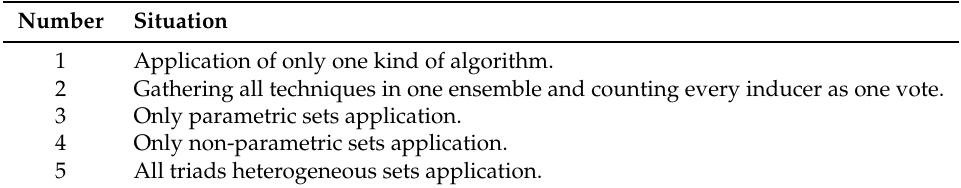
Table 12. Situations to evaluate.